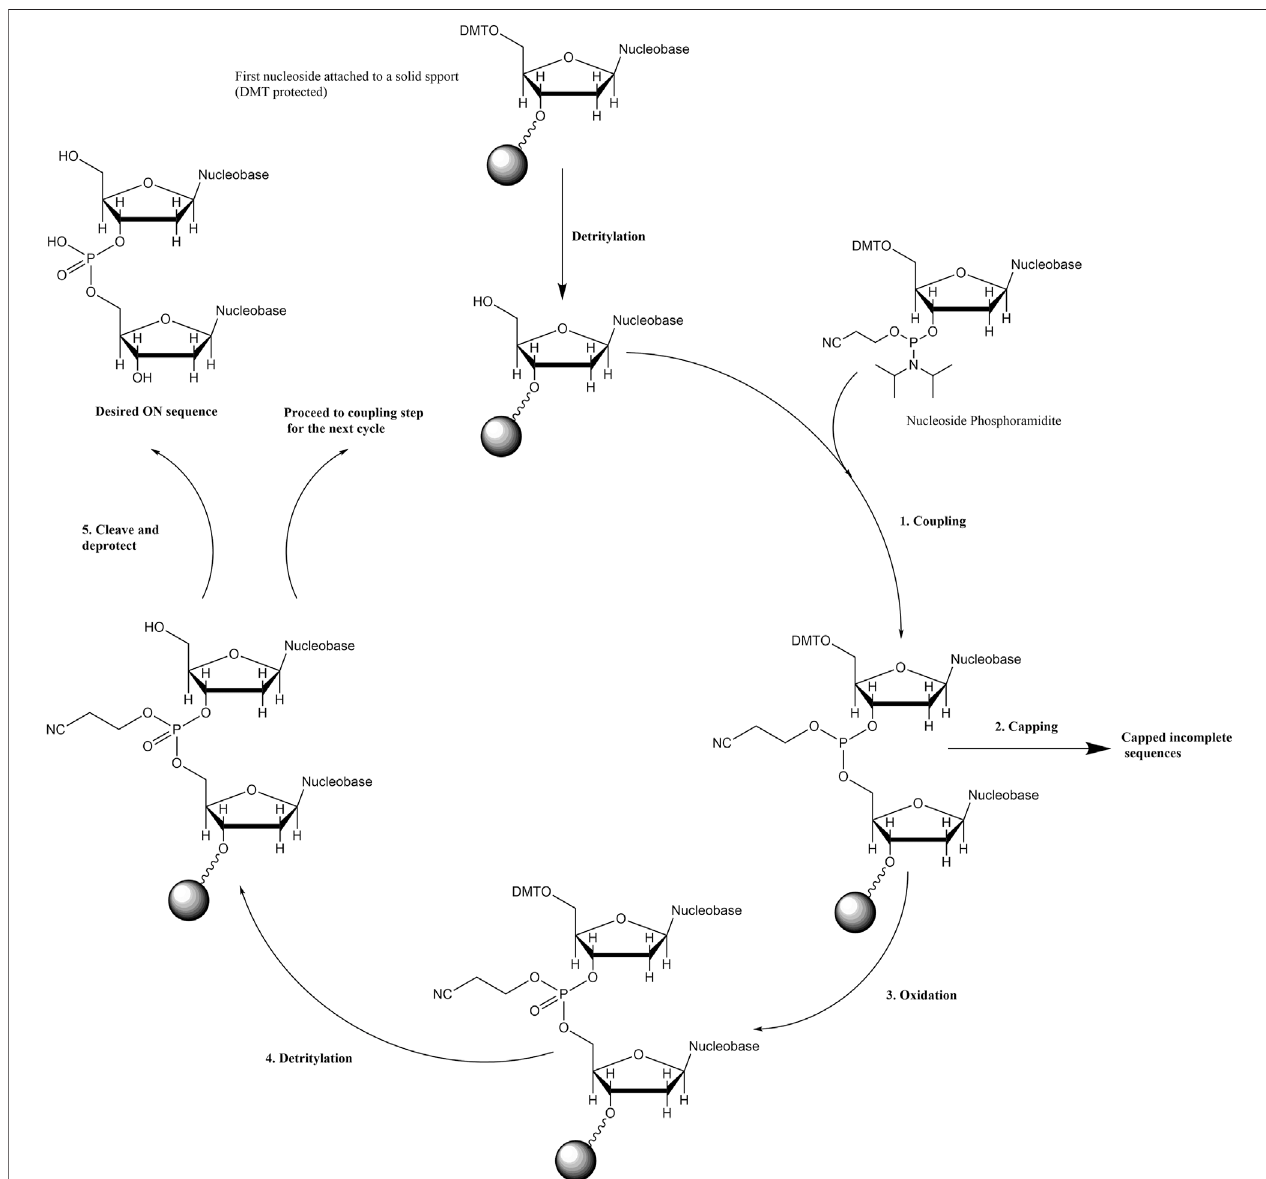
SCHEME 2 | General scheme for solid-phase phosphoramidite-based (3 ′ to 5 ′ ) ON synthesis.